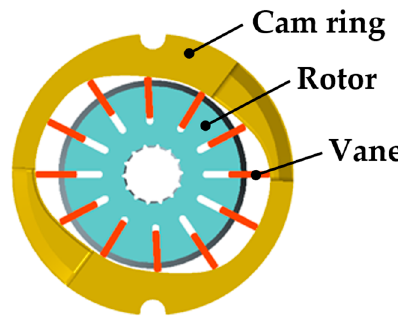
Figure 1. Inner parts of a balanced vane pump consisting of the rotor, twelve vanes, and the cam ring.